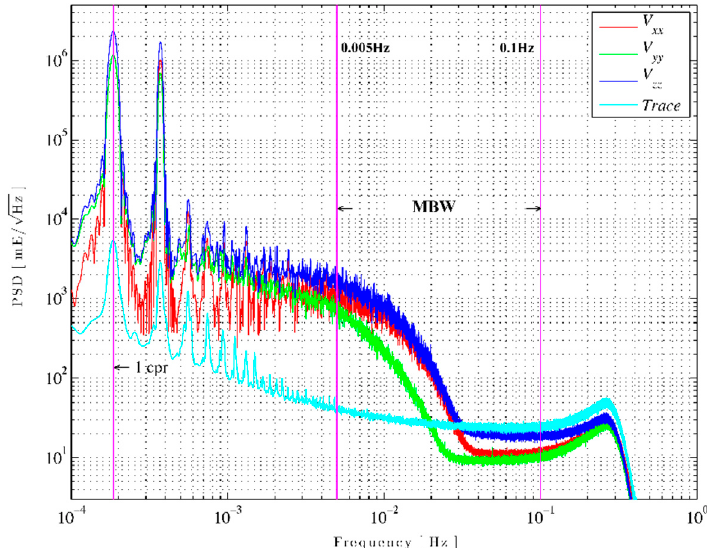
Figure 1. Power spectral densities of the diagonal components ( V xx , V yy , and V zz ) and trace of the Gravity field and steady state Ocean Circulation Explorer (GOCE) gravity gradient tensor.